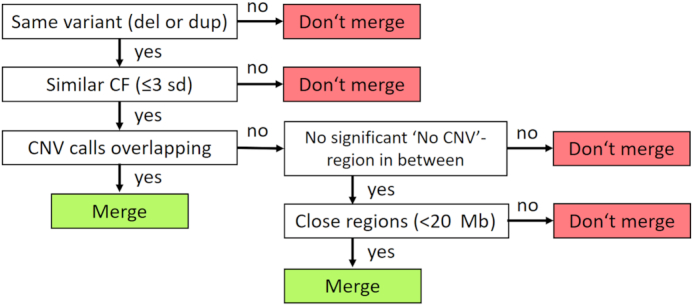
Decision tree for the merging process. Two CNV calls are merged according to the displayed merging scheme. Defining close regions as being separated by <20 Mb allows for merging of 2 regions separated by a centromere, which is ≤7.4 Mb, and for detecting monosomy or trisomy of the smallest chromosomes by only 2 significant regions. sd: standard deviations.